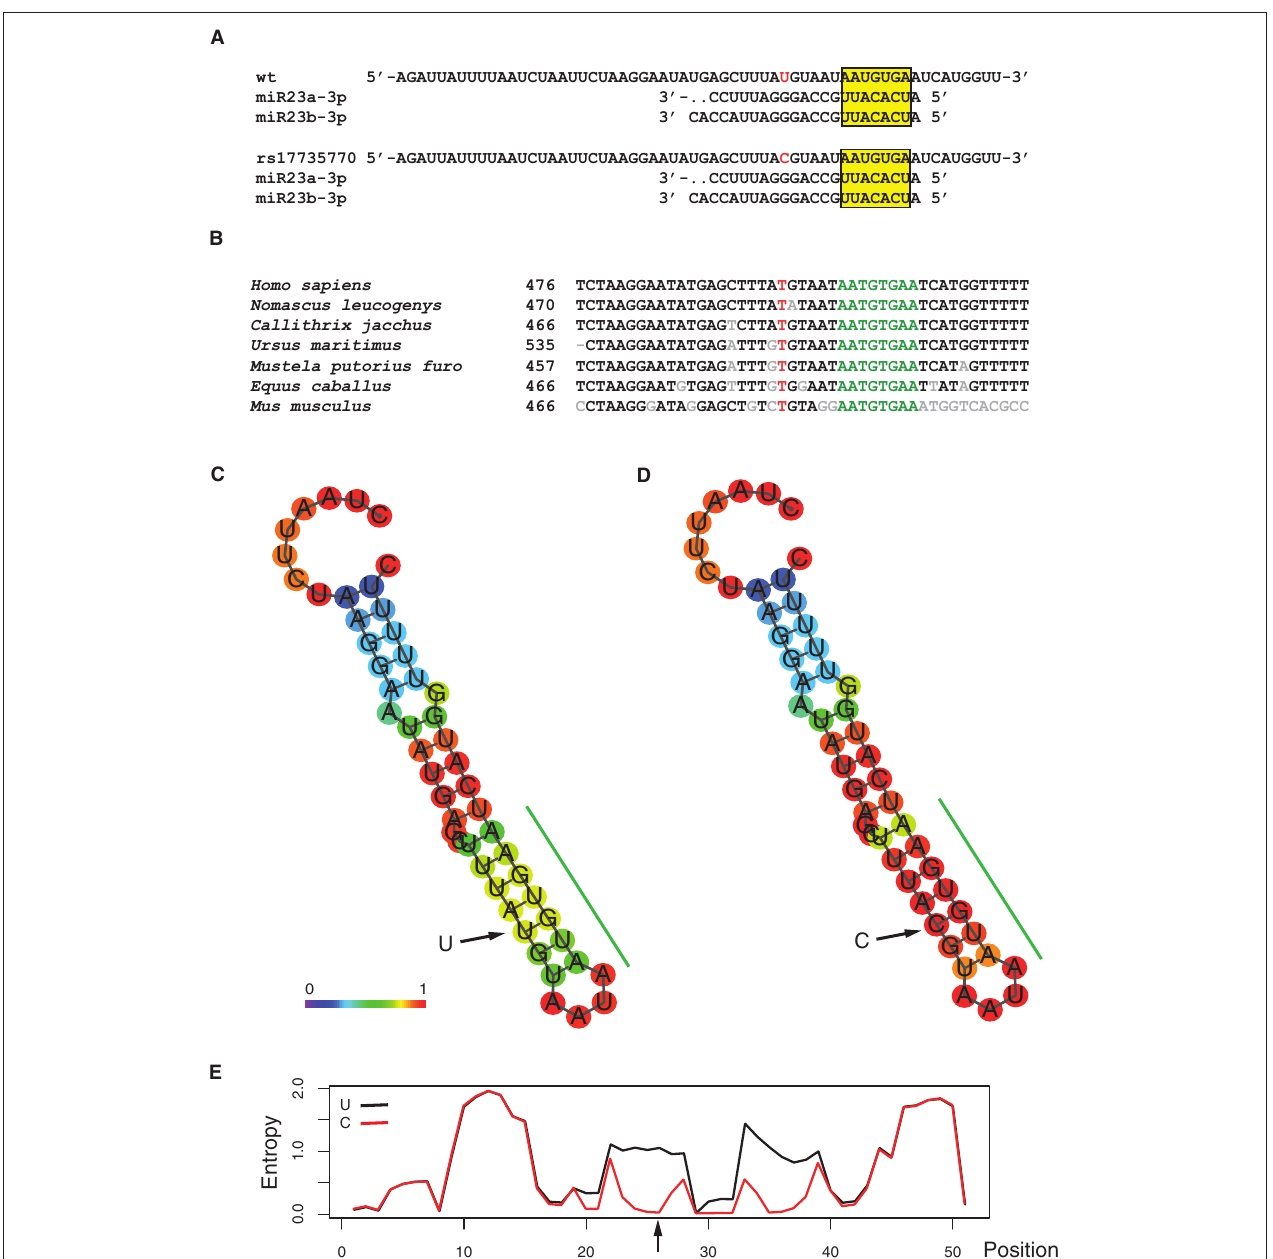
FIGURE 1 | Predicted functional significance of the of the rs1773577 variant. (A) Context sequence of the rs1773577 variant aligned with mammalian species. Numbers indicate the position on the mRNA. The position affected by the rs1773577 variant is red, while the miR28ab binding site predicted by the TargetScan software.is shown in green. Non-conserved positions are indicated in gray. Reference sequences shown are: NM_006273.3 ( Homo sapiens ); XM_003278361.3 ( Nomascus leucogenys ); XM_002748371.3 ( Callithrix jacchus ); XM_008695392.1 ( Ursus maritimus ); XM_004747090.2 ( Mustela putorius furo ); XM_005597581.1 ( Equus caballus ); NM_013654.3 ( Mus musculus ). (B) Alignment of the predicted miR23 binding sequence with the corresponding mature miR23a and b. (C–E) RNAfold algorithm analysis of the effect of the rs1773577 variant in its RNA structural context. Panel (C) shows a minimum free energy (MFE) drawing of a local hairpin for the wt (T) allele pairing prediction, while panel (D) shows the same prediction for the variant (C) . Color coding indicates base-pair probabilities as shown on the figure, at the bottom of panel (C) . The green bar on the side of the predicted structures indicates the miR23ab predicted binding site. (E) Graphical representation of the level of entropy for each position along both structures, as